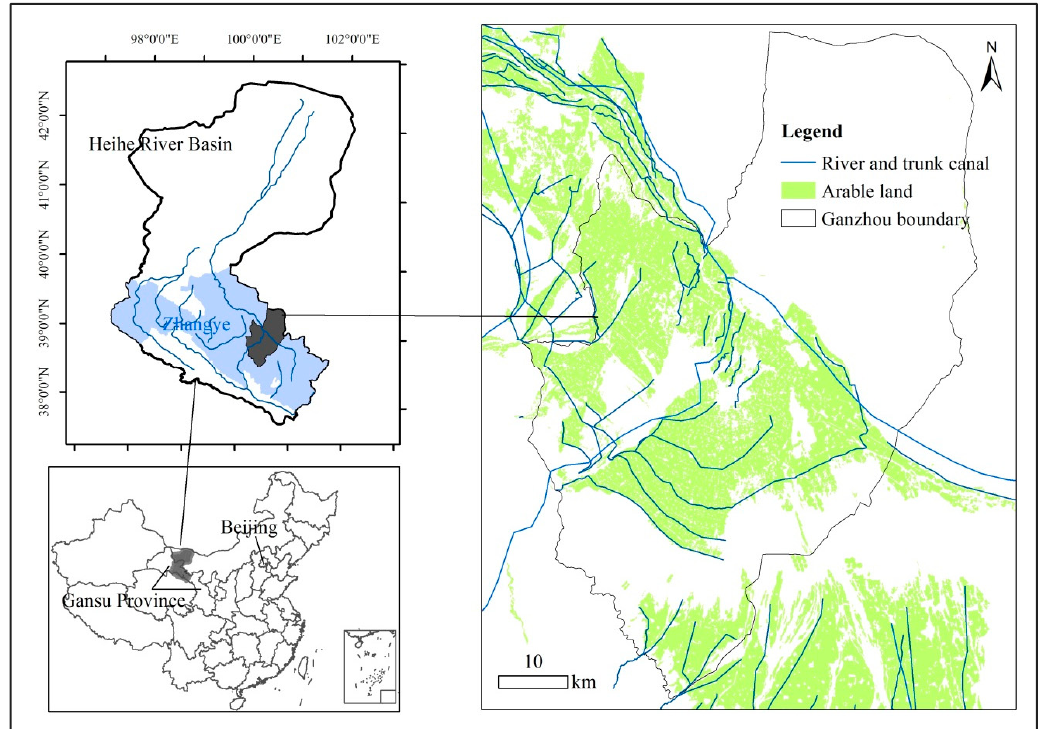
Figure 1. Location map of the study area.